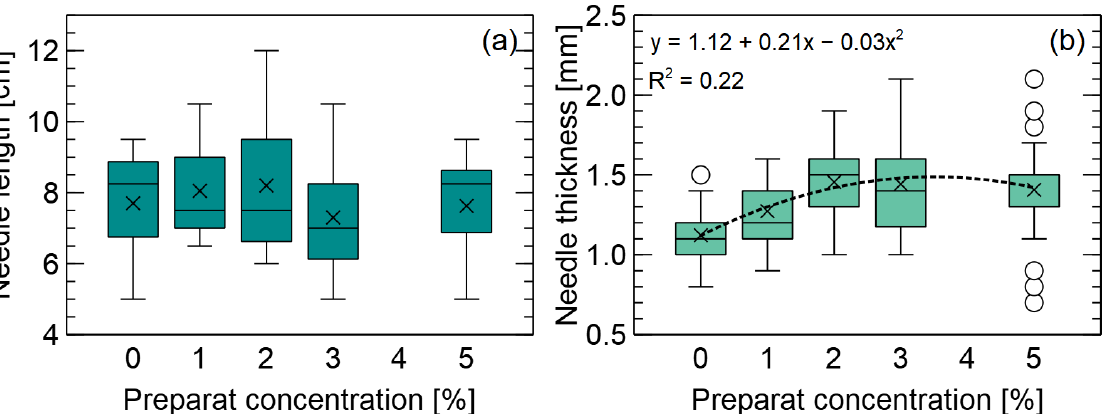
Figure 3. Pines’ needles length ( a ) and thickness ( b ) versus silicon concentration. In sub-Figure ( b ), the dashed curve represents the linear regression fit of the data. The regression equation with the fitted parameters and the model’s R 2 values are printed. The regression parameters are statistically significant at p < 0.0001. For the case presented in sub-Figure ( a ) the regression parameters were not statistically significant at the p -value level of 0.05, thus, the fit is not presented. In the plots, boxes span from the 1st to 3rd quantile, with the median indicated by a line, whiskers indicating a 1.5 inter- quantile range, the × symbol indicating the mean value, and circles indicating outlier observations.